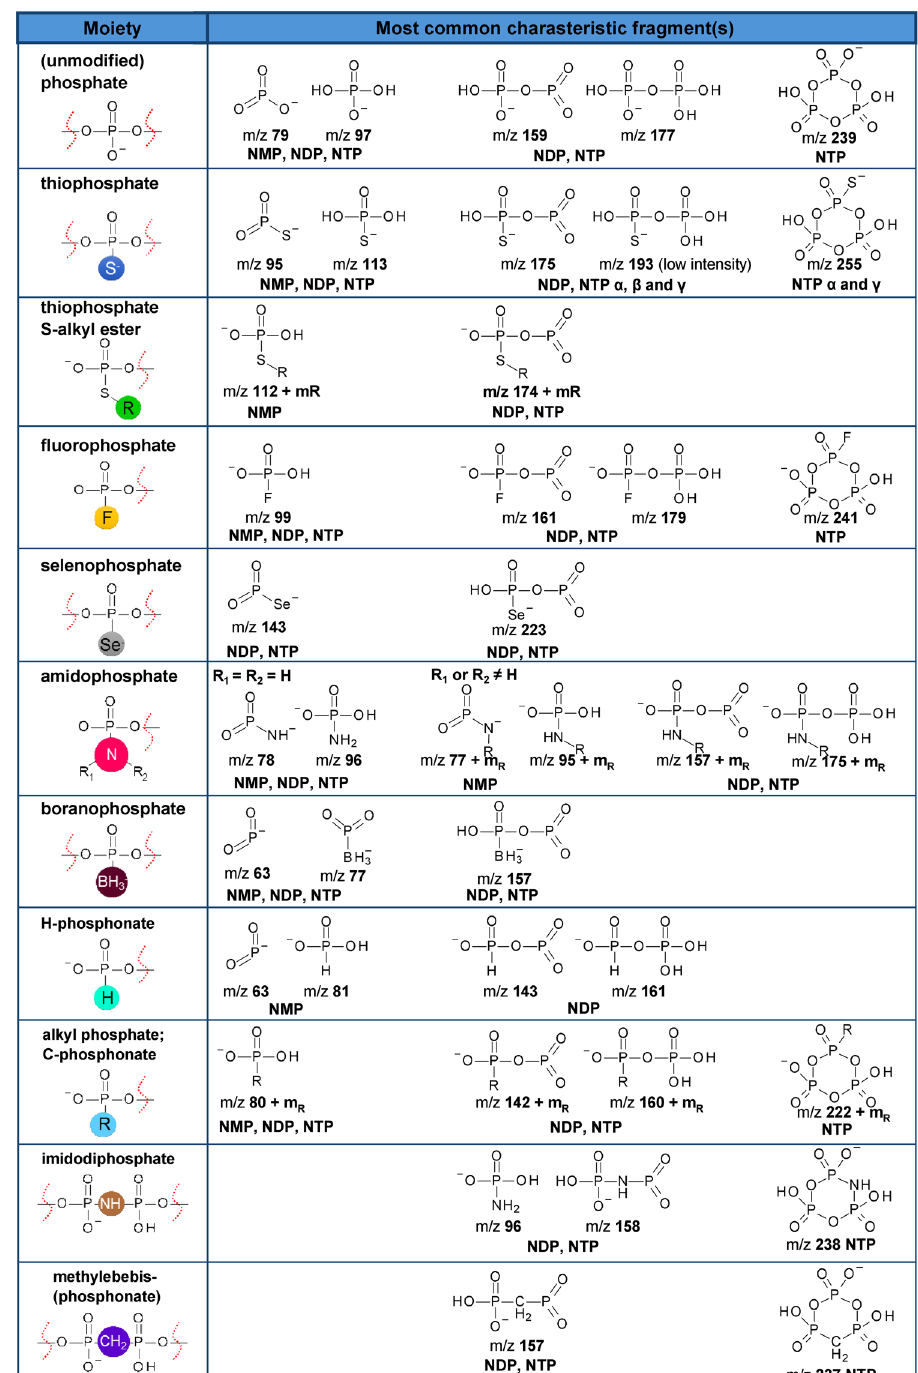
Figure 4. Characteristic fragmentation ions present in the ESI( − )MS/MS spectra of phosphate-modified